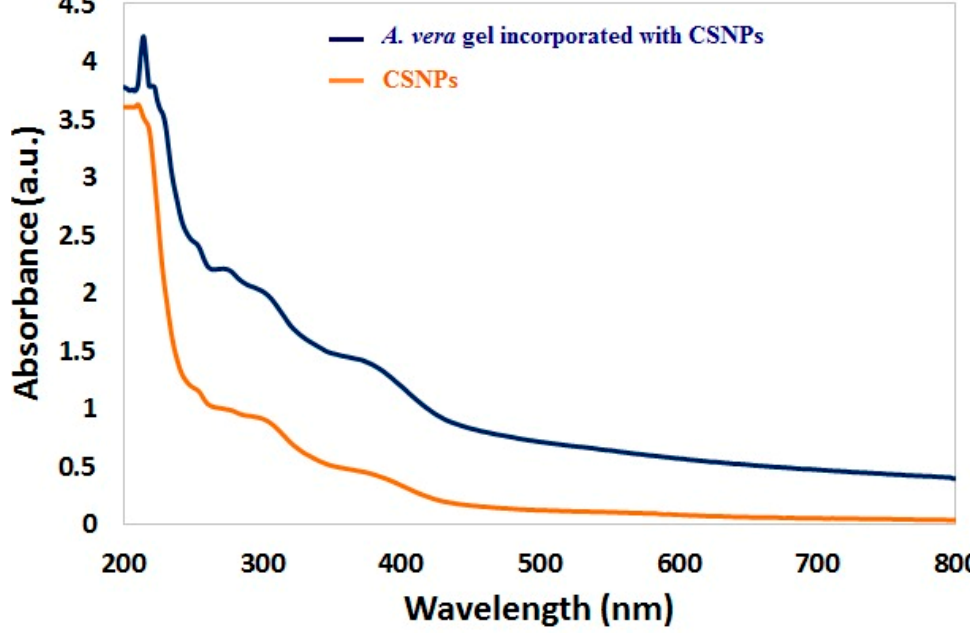
Figure 3. UV–vis spectra of CSNPs and A. vera gel incorporated with CSNPs.